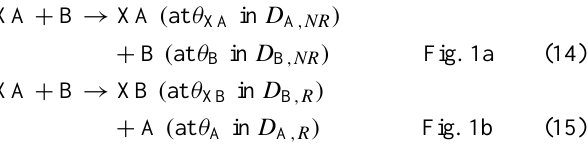
Fig. 2. Schematic diagram of the isotopic distributions of XA, XB, A and B, as a function of their scattering angles in the cross beam experiment shown in Fig. 1. The probability for detecting XA and B at θ XA = θ B = θ are strictly equal (and similarly for XB and A). The reactive and non-reactive overall differential cross sections are reported in the lower part of the